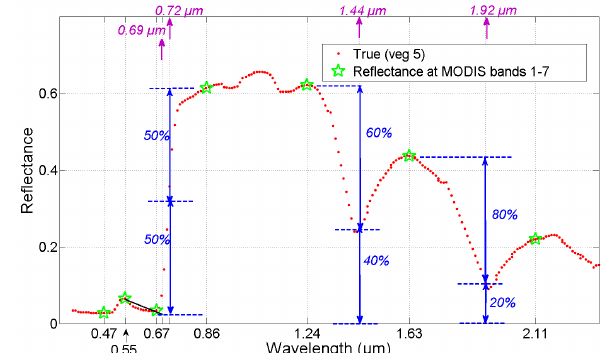
Fig. 4. (a) Downward fluxes at the TOA and surface. The x-axis is the wavelength (from 0.3 to 2.5µm) labeled with MODIS bands 1– 7; the red curve represents the incoming solar radiation at the top of the atmosphere (TOA); the green curve represents the downward ra- diation reaching the surface. The simulation was done with the fol- lowing inputs: no boundary layer aerosols, SZA=30 degrees, trop- ical atmospheric profile, and surface albedo being as the red curve in Fig. 2. (b) The three missing features by linearly connecting the reflectance at MODIS bands 1–7. The x-axis is the wavelength from 0.3 to 2.5µm labeled with MODIS bands 1–7; the dotted red curve represents the reflectance as shown in Fig. 2; the solid blue line represents the linearly connected reflectance at MODIS bands 1–7; the shaded areas represent three distinct missing features: missing vegetation red edge feature at around 0.7µm, and the missing water absorption features at around 1.44 and 1.92µm.